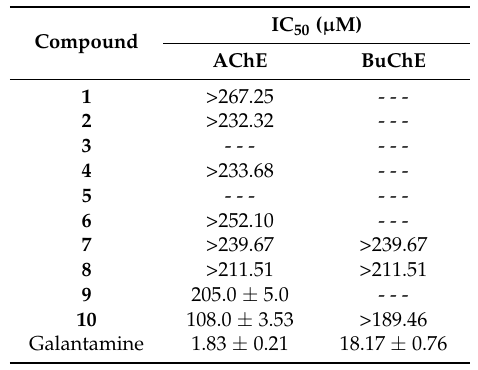
Table 4. The anticholinesterase activity of the